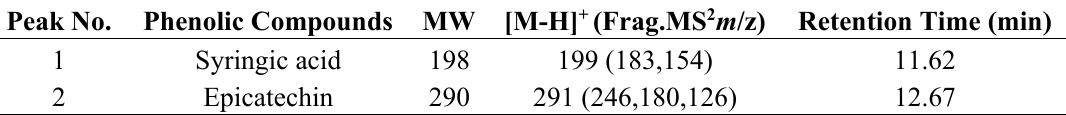
Table 2. Spectral information of LC-TOF-MS for two phenolic compounds. Peak No.